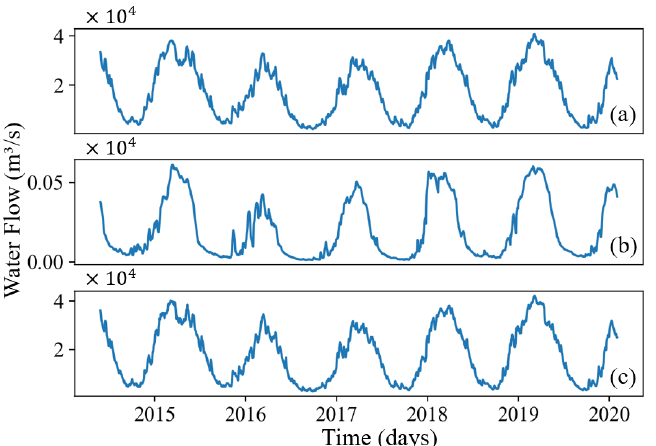
Figure 3. Original time series dataset of Mamoré ( a ), Abunã ( b ) and Madeira ( c )